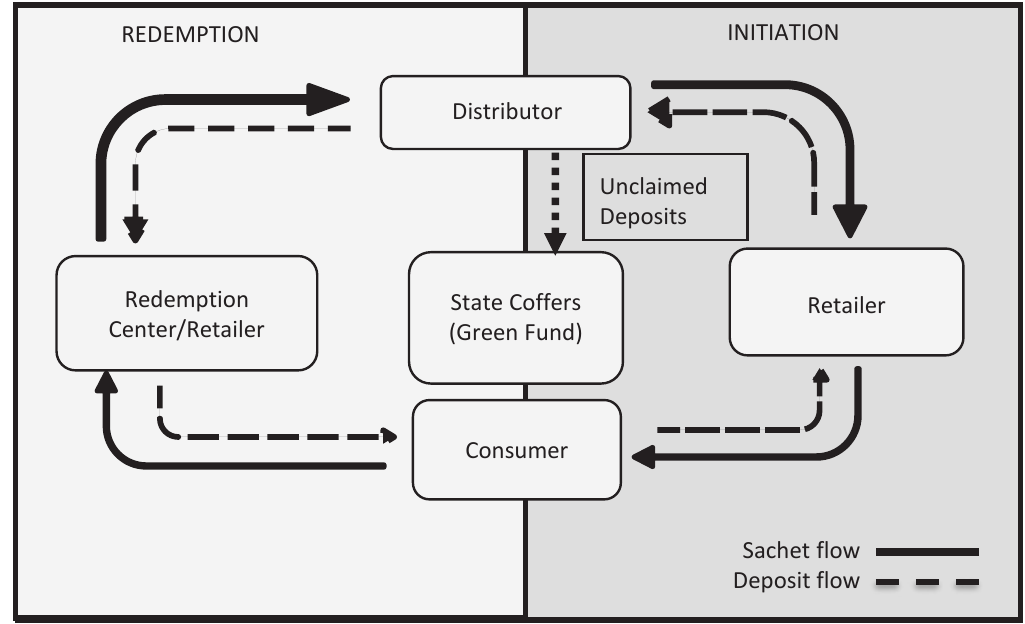
Figure 1. The conceptual framework of the mechanics of the deposit-refund